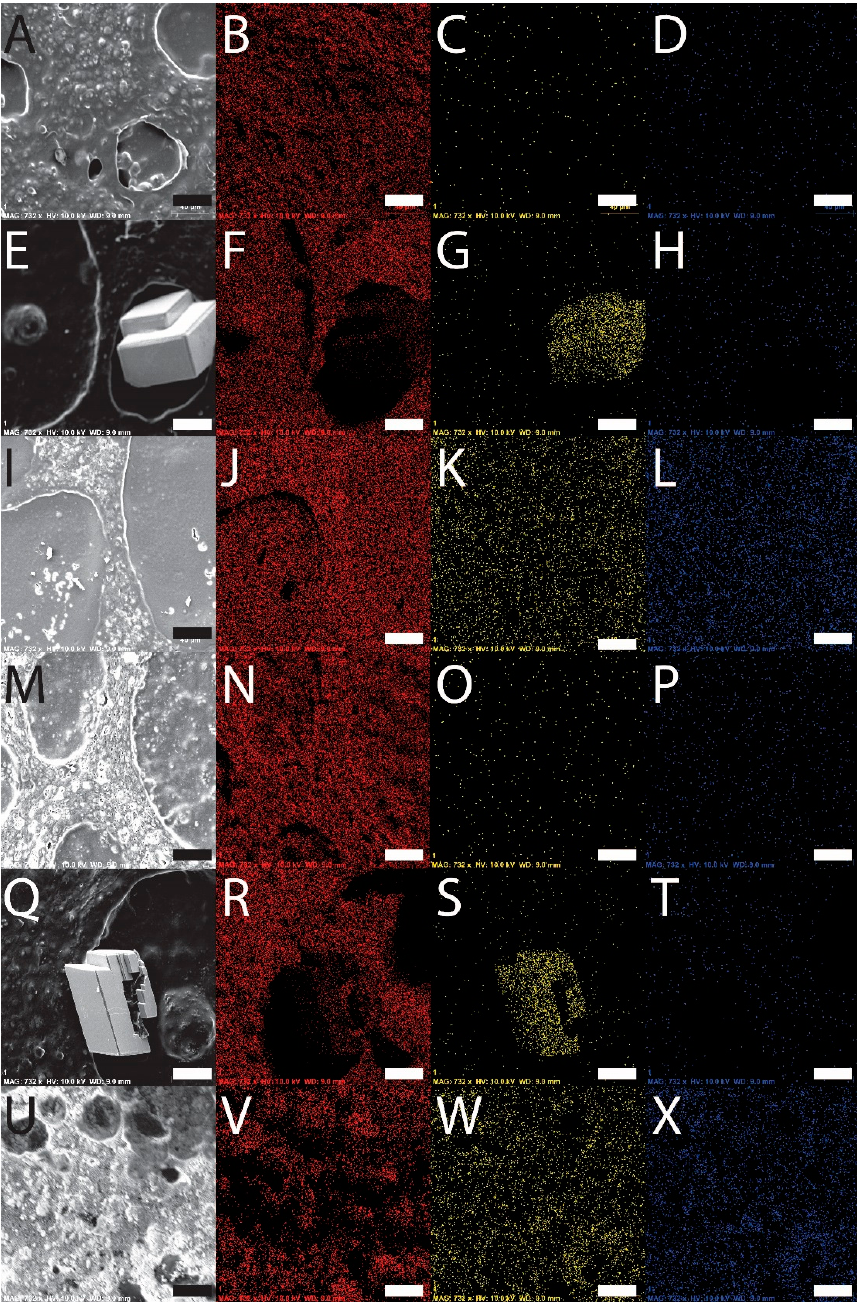
Figure 2. SEM-EDS analysis of films. ( A – D ) PBT-50; ( E – H ) PBT-50-CaCO 3 ; ( I – L ) PBT-50-CaPO 4 ; ( M – P ) PBTAT-50; ( Q – T ) PBTAT-50-CaCO 3 ; ( U – X ) PBTAT-50-CaPO 4 ; ( A , E , I , M , Q , U ) secondary electron SEM image; ( B , F , J , N , R , V ) carbon, red; ( C , G , K , O , S , W ) calcium, yellow; ( D , H , L , P , T , X ) phosphorous, blue. The scale bar represents 40 µm.